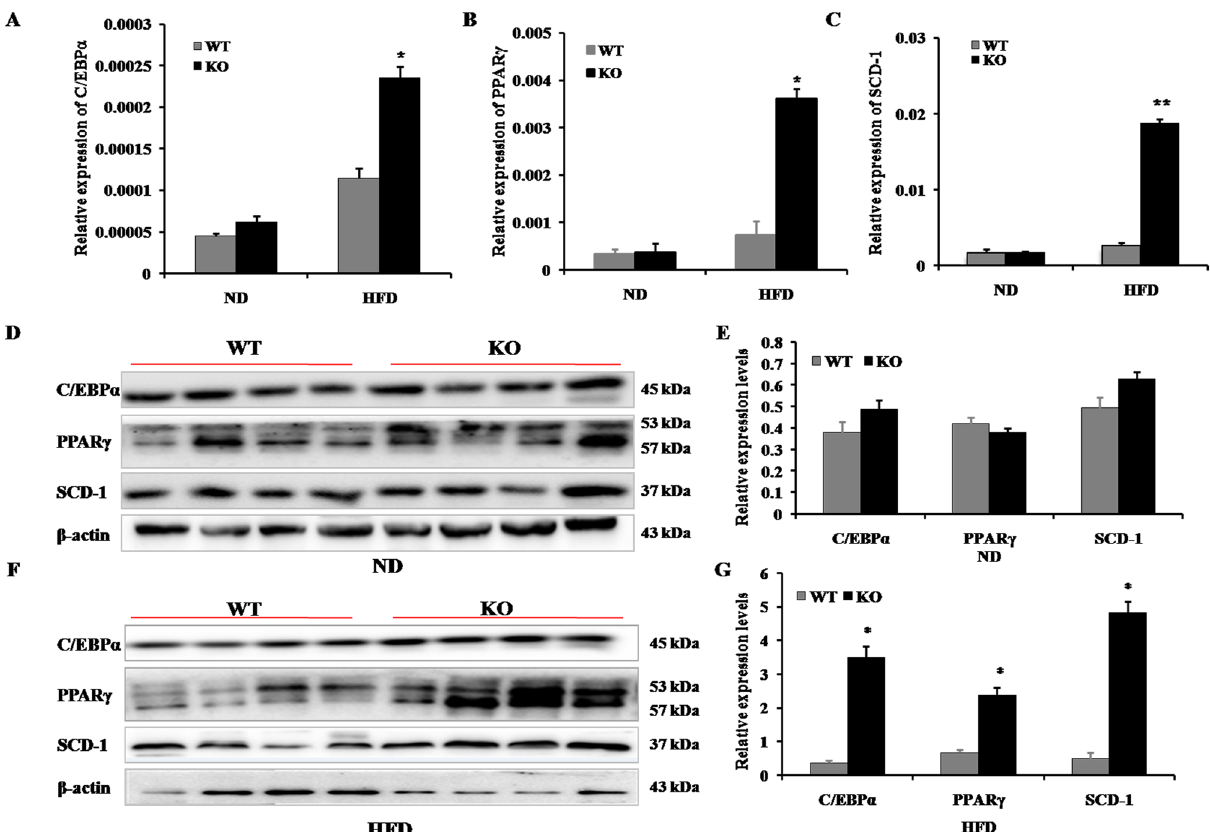
Figure 4. MiR-125b-2 increased expression levels of fat synthesis-associated genes. ( A – C ) Expression levels of C/EBPα, PPARγ, and SCD-1 mRNA in WT and KO mice fed a ND or HFD. SCD-1, PPARγ, and C/EBPα were significantly increased in KO mice fed a HFD. ( D , E ) Expression levels of C/EBPα, PPARγ and SCD-1 protein in WT and KO mice fed a ND. ( F , G ) Expression levels of C/EBPα, PPARγ and SCD-1 protein in WT and KO mice fed a HFD. C/EBPα, PPARγ, and SCD-1 protein expression was significantly increased in KO mice fed a HFD. The images displayed in Figures D and F are cropped blots, the full-length blots of ( D , F ) are presented in Supplementary Fig. 2. Data are presented as mean ± SE (* P < 0.05, ** P < 0.01, n = 8 mice per